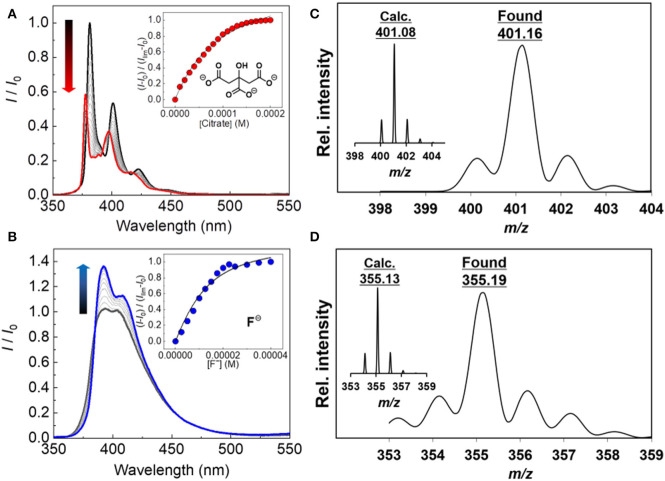
Fluorescence spectra of (A) 1 in DMSO upon addition of citrate at 25°C (0–200 μM) and (B) 2 in DMSO upon addition of fluoride at 25°C (0–40 μM). [1] = [2] =10 μM, λex = 340 nm for 1 and 2. ESI-MS spectrum (negative) of (C) the 1–citrate complex (inset: calculated isotope pattern for C22H14BO7-), and (D) the 2–fluoride complex (inset: calculated isotope pattern for C23H17BFO2-).